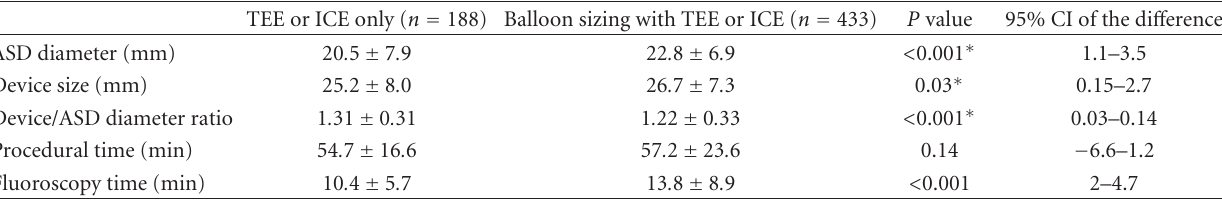
Table 3: Overall comparison of ASD diameter, device size, device/diameter of defect ratio, procedural time, and fluoroscopy time in successful cases of patients who had, or had not, used balloon sizing ( n = 621).